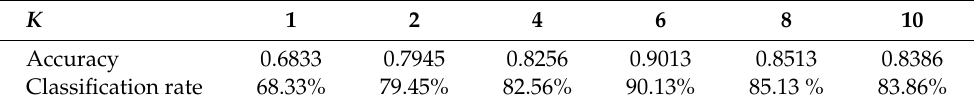
Table 1. K-nearest-neighbour (KNN) prediction accuracy for simulated data.